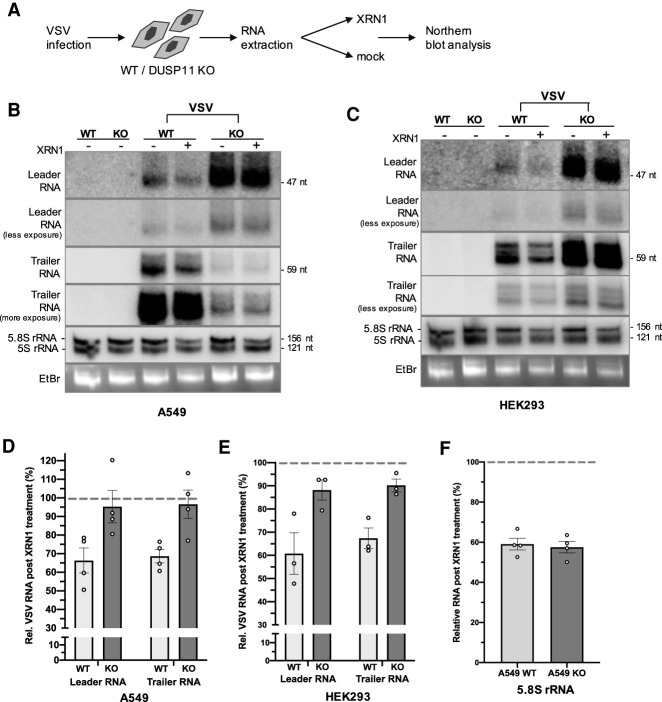
DUSP11 promotes RNA virus replication by dephosphorylating viral RNA PAMPs. (A) Schematic diagram of the VSV leader and trailer RNA 5′ end characterization assay. RNA was extracted from A549 or HEK293 WT and DUSP11 KO cells infected with VSV at MOI of five PFU/cell for 24 h and treated with or without 5′-monophosphate-dependent exonuclease XRN1. Purified RNA was then subject to Northern blot analysis. (B) Northern blot analysis on VSV leader, trailer and small RNAs purified from A549 WT/DUSP11 KO cells infected with WT VSV. (C) Northern blot analysis on VSV leader, trailer, and small RNAs purified from HEK293 WT/DUSP11 KO cells infected with WT VSV. (D) Graphical representation of the relative band density percentage ratio (+XRN1/−XRN1) of VSV leader and trailer RNA in A549 WT and DUSP11 KO cells as determined by Northern blot analysis in B. (E) Graphical representation of the relative band density percentage ratio (+XRN1/−XRN1) of VSV leader and trailer RNA in HEK293 WT and DUSP11 KO cells as determined by Northern blot analysis in C. (F) Graphical representation of the relative band density percentage ratio (+XRN1/−XRN1) of 5.8s rRNA in A549 WT and DUSP11 KO cells as determined by Northern blot analysis in B. Data are derived from n = 4 independent replicates for D and F and n = 3 independent replicates for E. In all panels, data are presented as mean ± SEM.